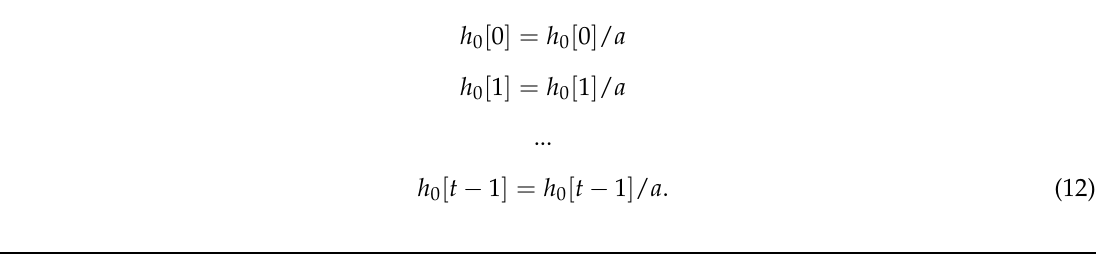
Algorithm 11 Analysis for L